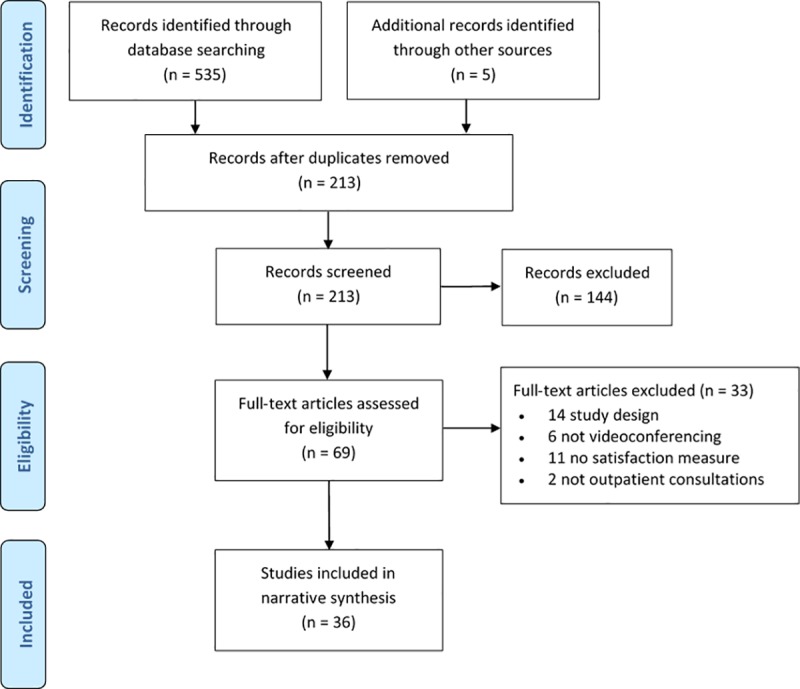
CONSORT diagram.